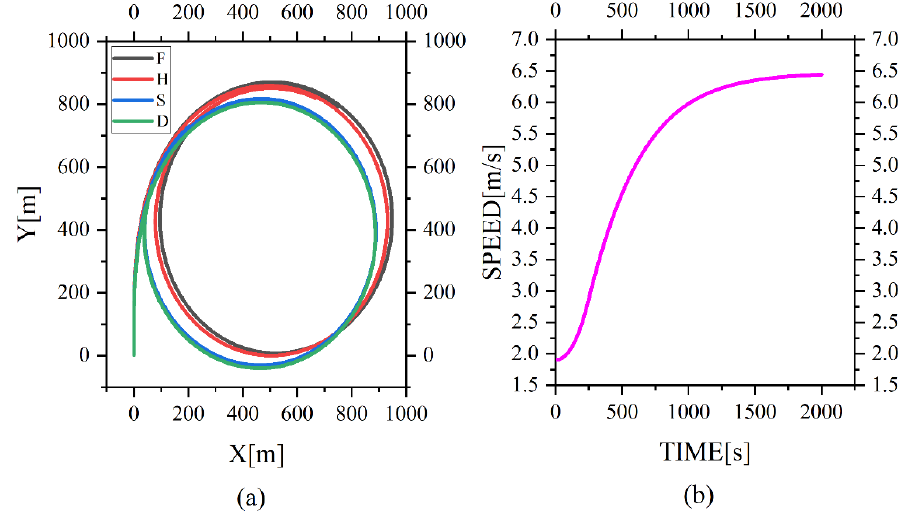
Figure 11. Simulation of the different telegraphs. ( a ) Turing circle at different telegraph; ( b ) Speed change from D to F .